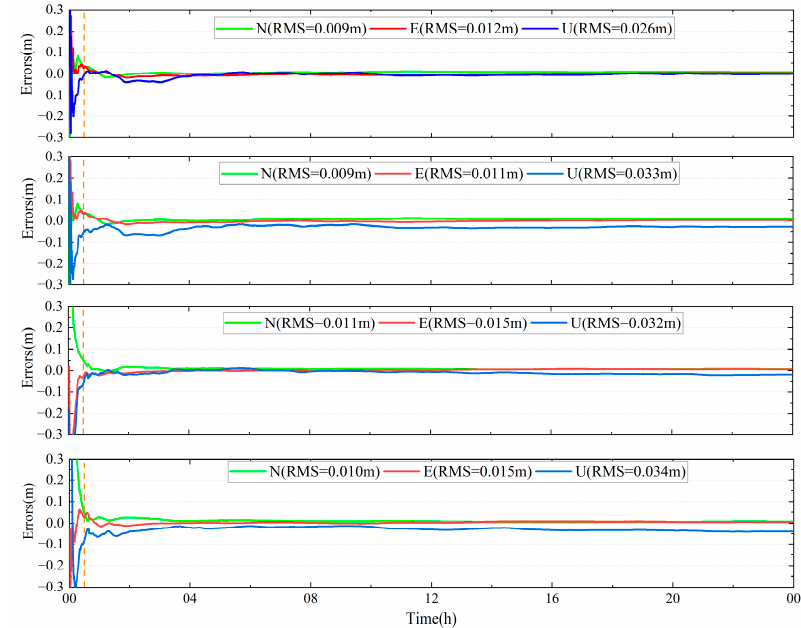
Figure 6. PPP-B2b position error for GAMG in the static mode (8 March 2022).